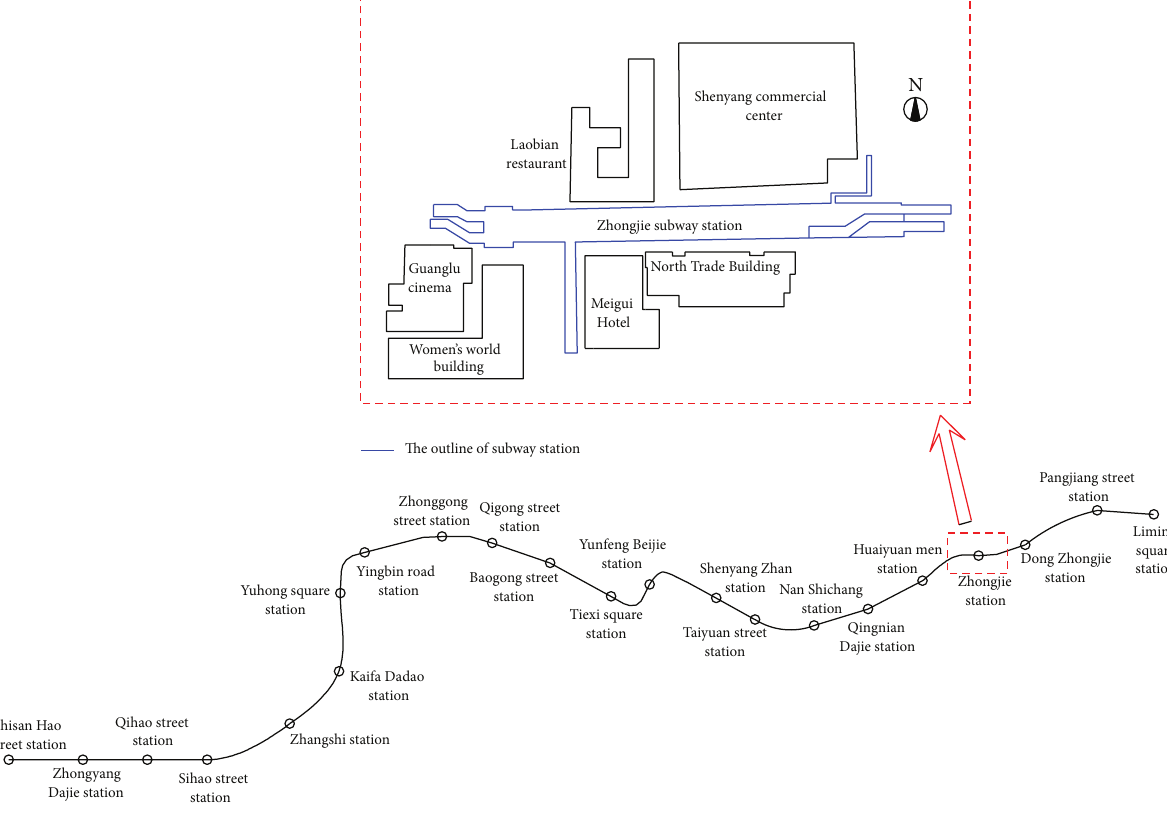
Figure 1: Main route of Shenyang Metro Line